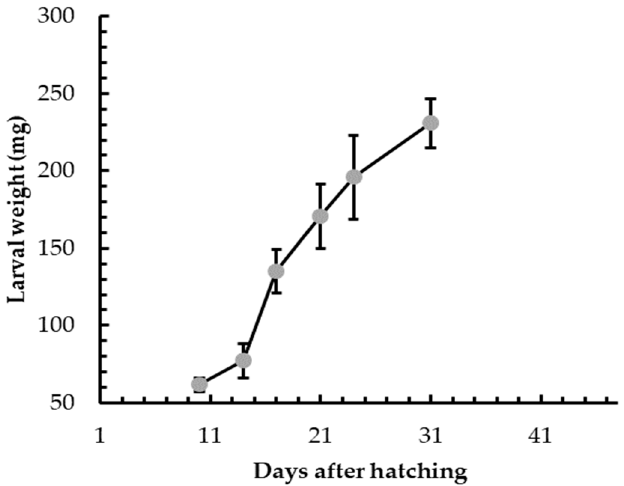
Figure 2. Development time of BSD larvae grown on VMD in mass rearing conditions. Bars refer to standard deviation.